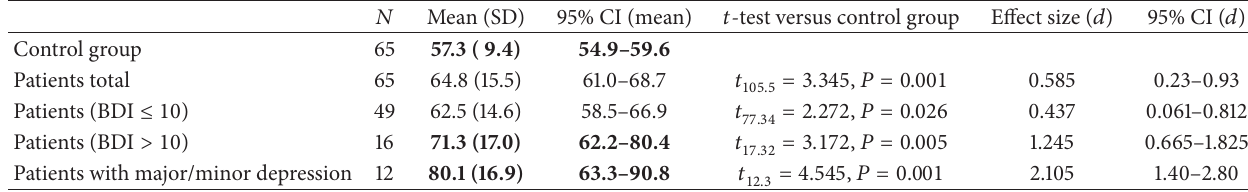
Table 2: Comparison of 5HT uptake rate (SUR) in healthy control subjects and patients with chronic HCV. 𝑁 Mean (SD) 95% CI (mean) 𝑡 -test versus control group Effect size ( 𝑑 ) 95% CI ( 𝑑